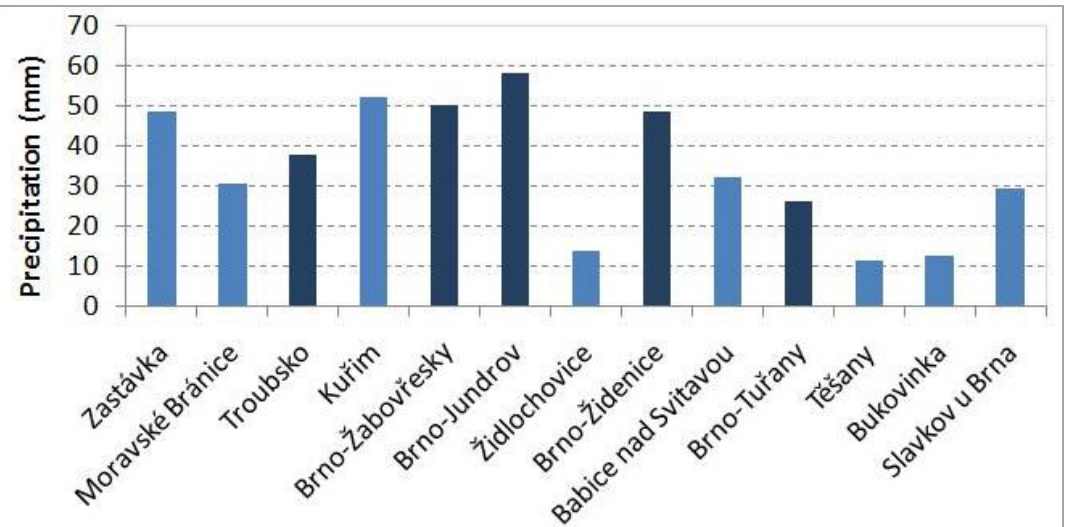
Fig. 3. Daily precipitation totals on 15 July 2009 in Brno